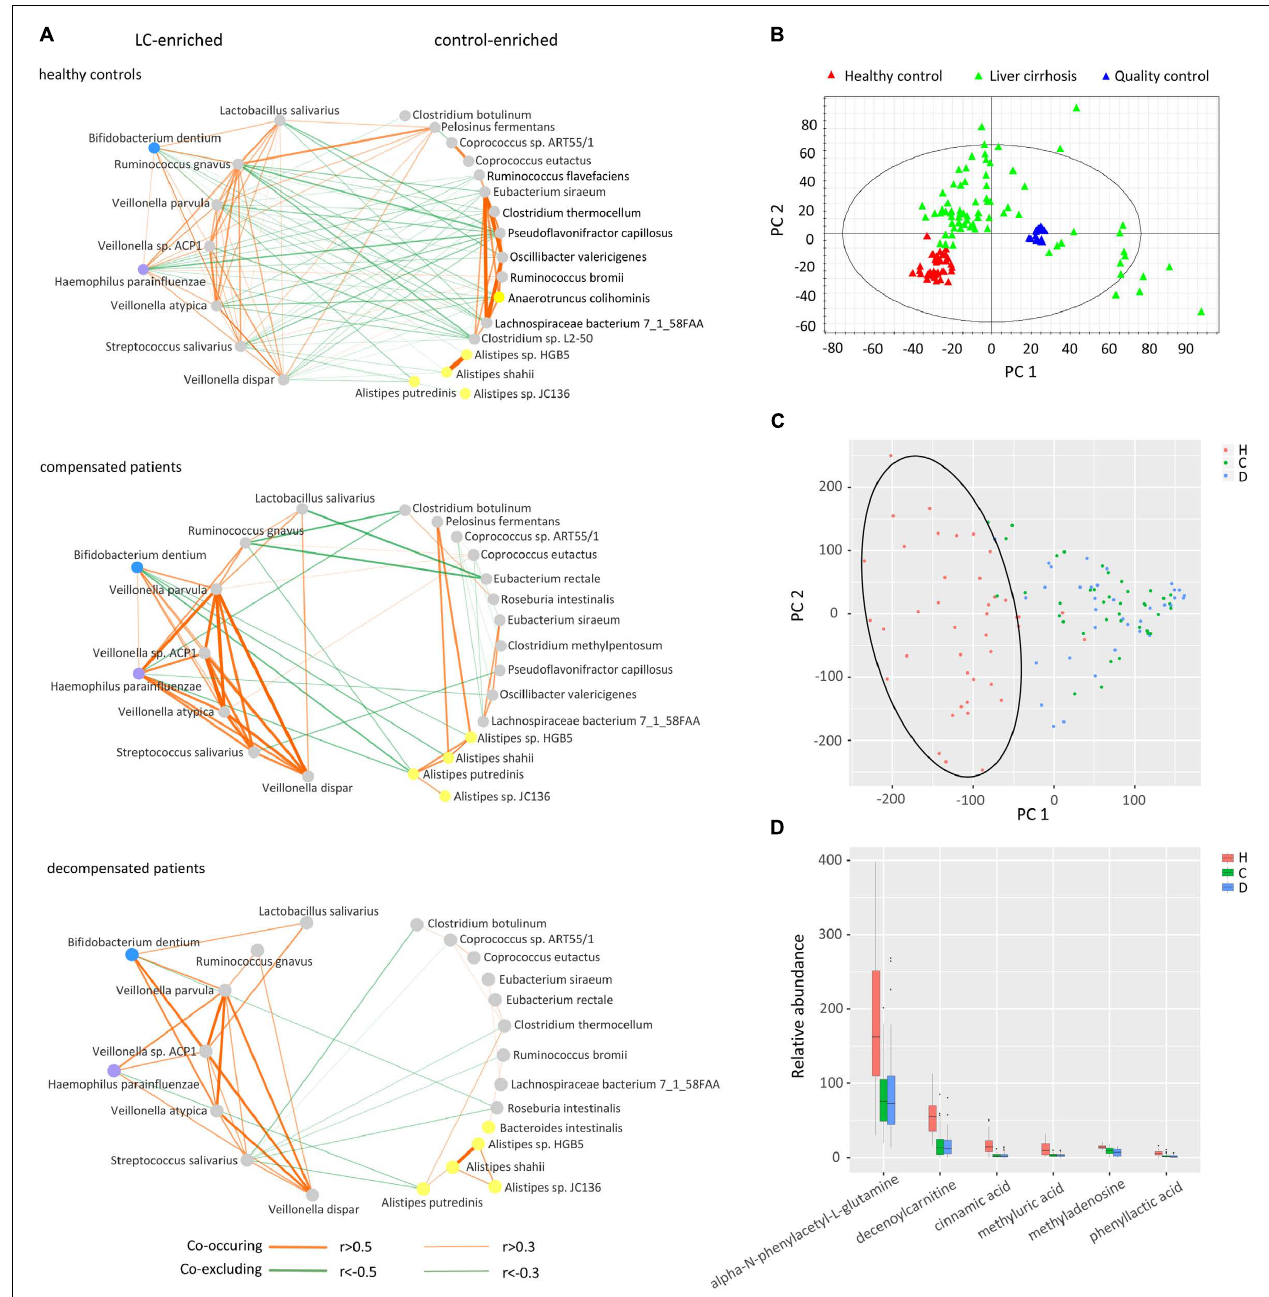
FIGURE 3 | Cross-talk of gut microbiome, score plots of urine metabolites in principal component analysis, and relative abundance of identified metabolites. (A) Correlation networks of the gut microbiome in healthy controls, compensated and decompensated patients. Red and green lines represent positive and negative regulatory networks. Nodes filled with gray, yellow, blue, and purple represent species from the phyla Firmicutes , Bacteroidetes , Actinobacteria , and Proteobacteria , respectively. (B) Score plot of healthy controls, liver cirrhotic patients and quality control samples based on raw metabolomic data without filtering. (C) Score plot of healthy controls, compensated and decompensated patients based on 75 differential metabolites. (D) Relative abundance of the six metabolites identified in healthy controls, compensated and decompensated patients.